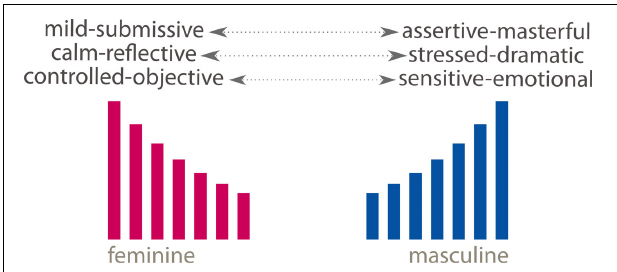
FIGURE 5 | Perceived Gendered propensities of music